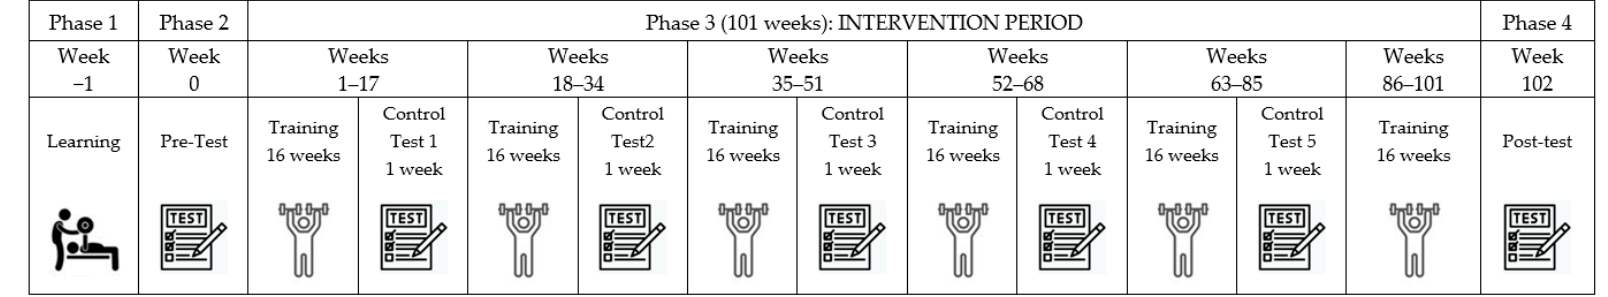
Figure 3. Figure 3. Temporalisation. Table 2. Timetable of the resistance training programme.